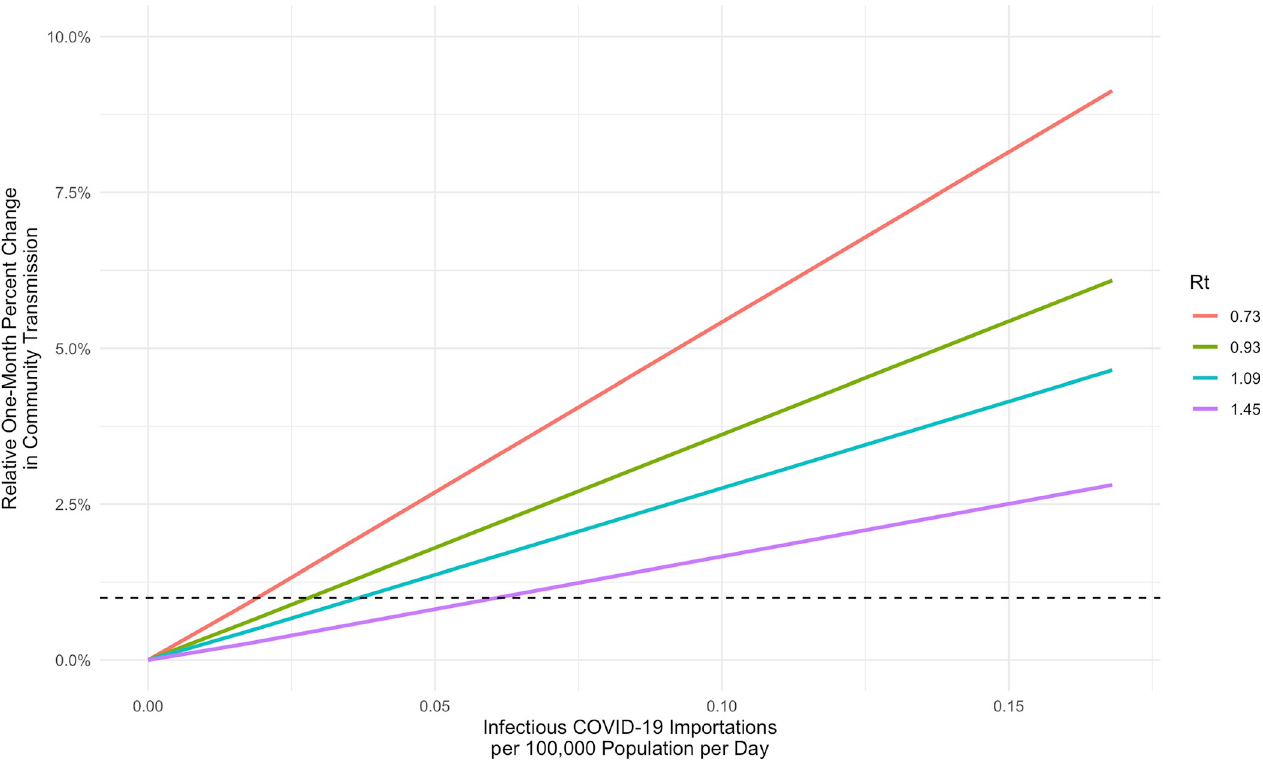
Fig 1. Linear relationship between daily COVID-19 case importations and the relative change in community transmission over the course of one-month by effective reproductive number (Rt) with recipient country COVID-19 prevalence at 0.1%. The horizontal dashed line at 1% represents the threshold of maximum allowable daily COVID-19